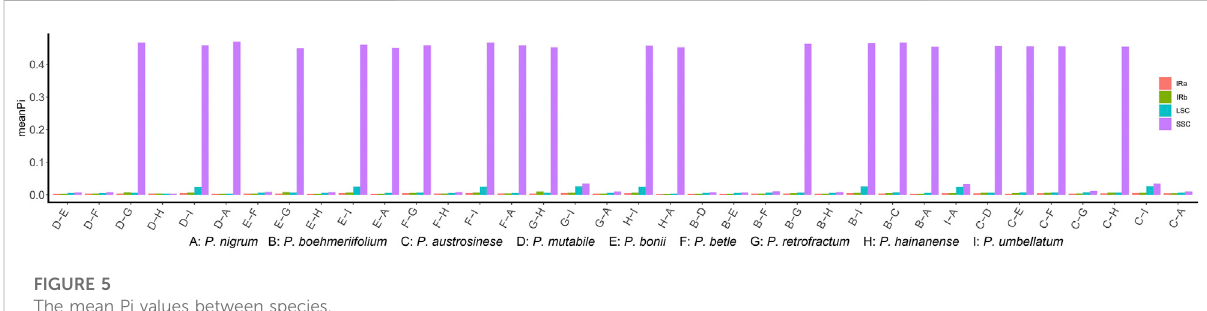
FIGURE 5 The mean Pi values between